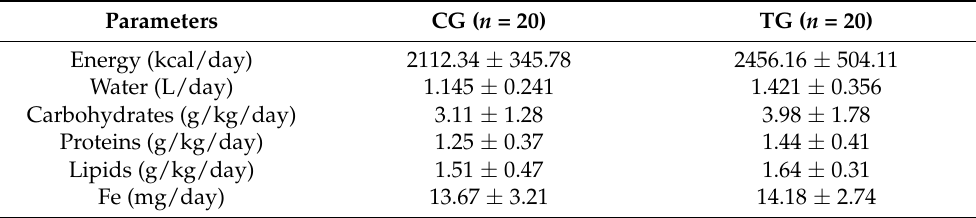
Table 3. Nutritional intake of participants.